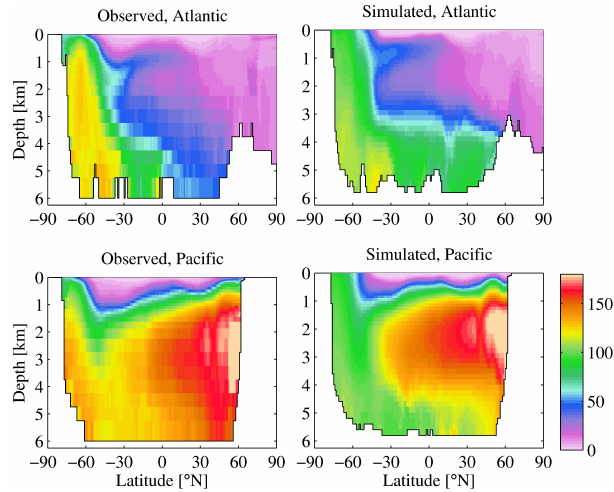
Fig. 9. Intercomparison of observational (left) and model (right) fields of zonally averaged silicic acid for the Atlantic (top) and Pacific (bottom) basins. Concentrations in mmol Si m − 3 . Fig. 7. Hovm¨oller diagrams of observational (World Ocean Atlas, 2009; left) and simulated (right) monthly surface silicic acid, averaged zonally for the Atlantic (top) and Pacific (bottom) basins. Concentrations in mmolSim − 3 .